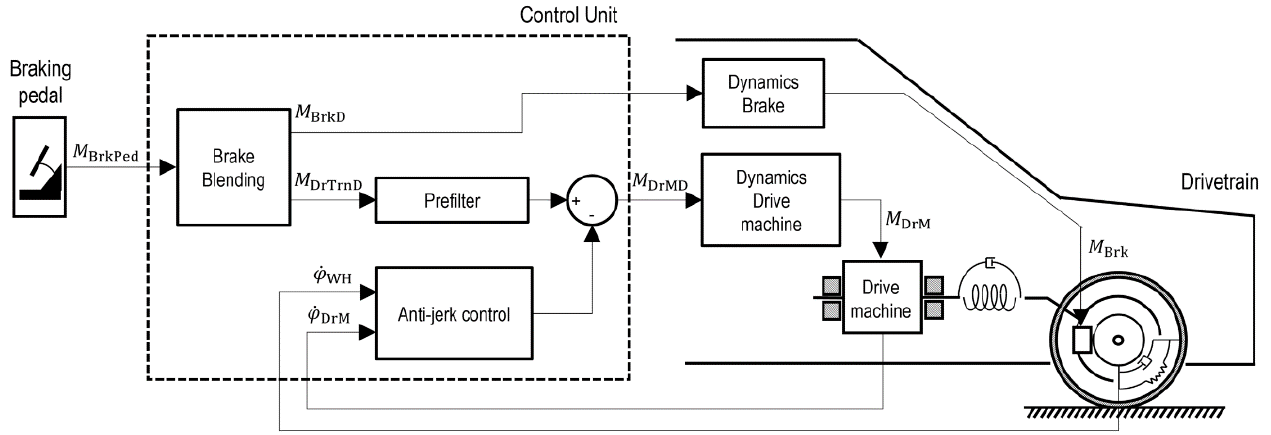
Figure 3. Overview of the system.